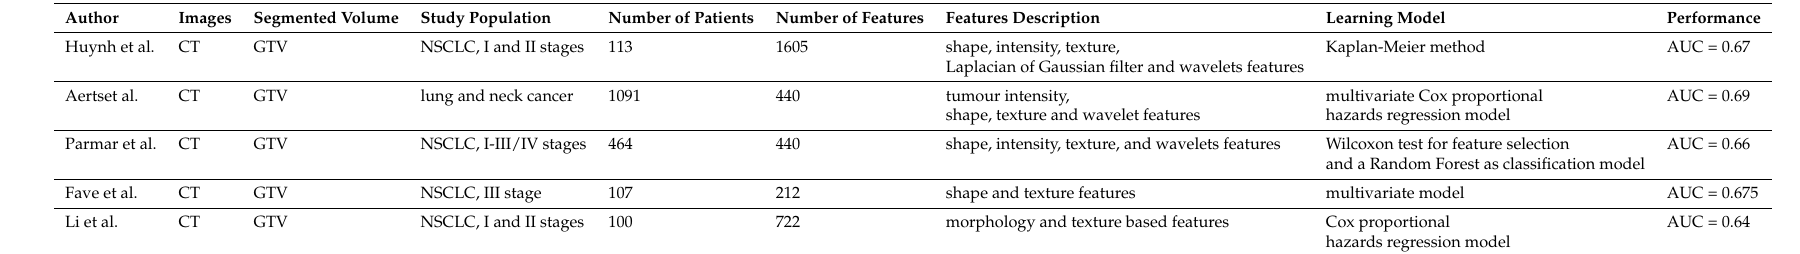
Table 1. Summary of the background on the radiomics approach to predict the Overall Survival in lung